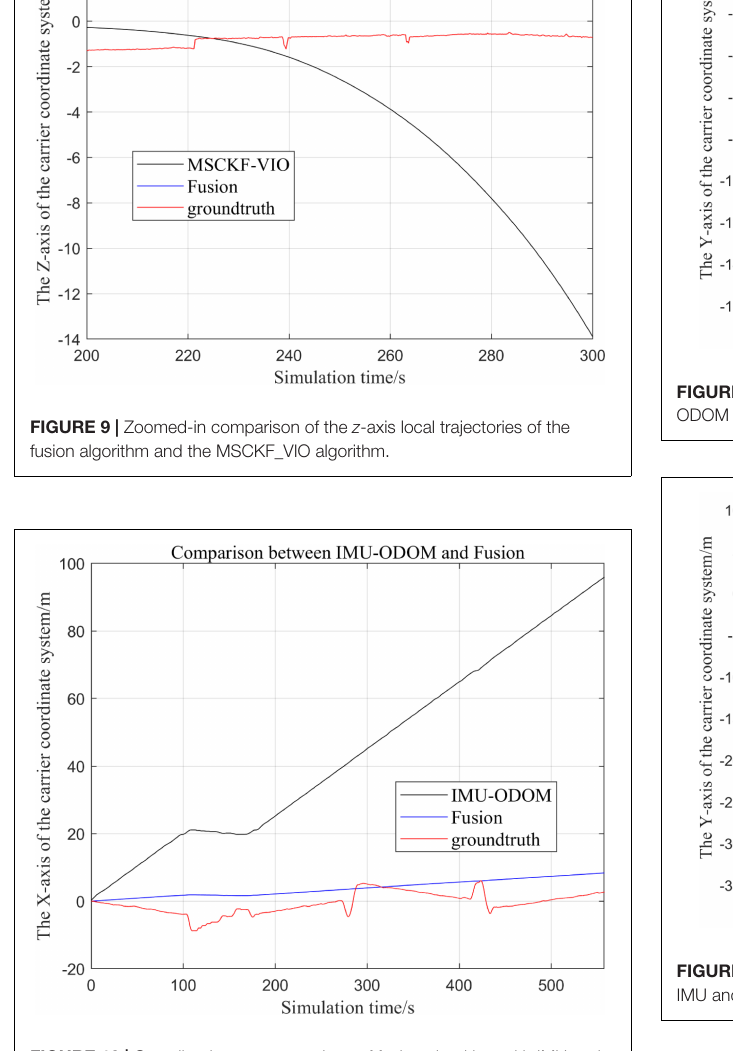
FIGURE 10 | Overall trajectory comparison of fusion algorithm with IMU and ODOM fusion algorithm in x -axis.